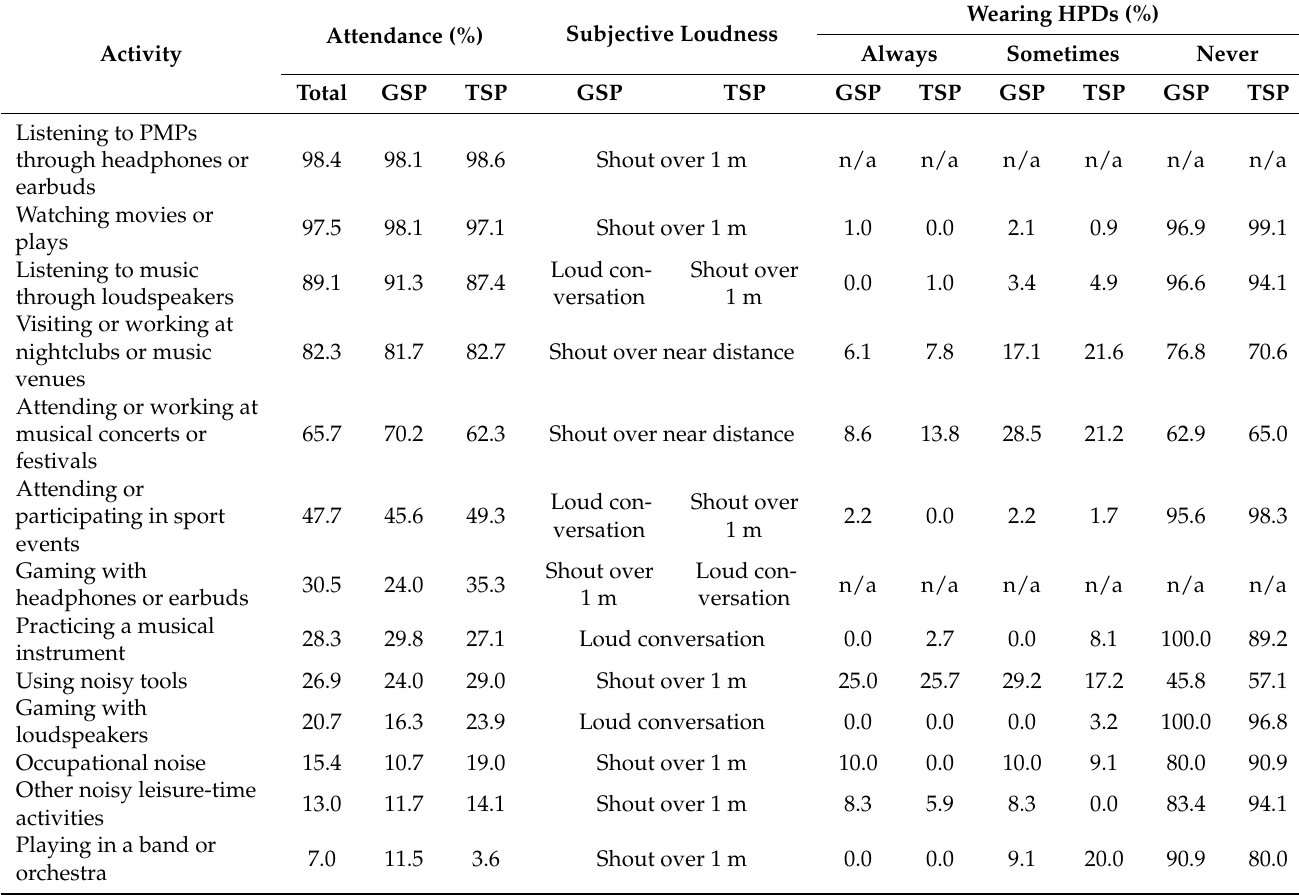
Table 2. Percentage of student’s attendance in each activity as well as the median loudness, and the percentage of subjects wearing hearing protector devices (HPDs), distributed for the students from the GSP ( n = 105) and TSP ( n =